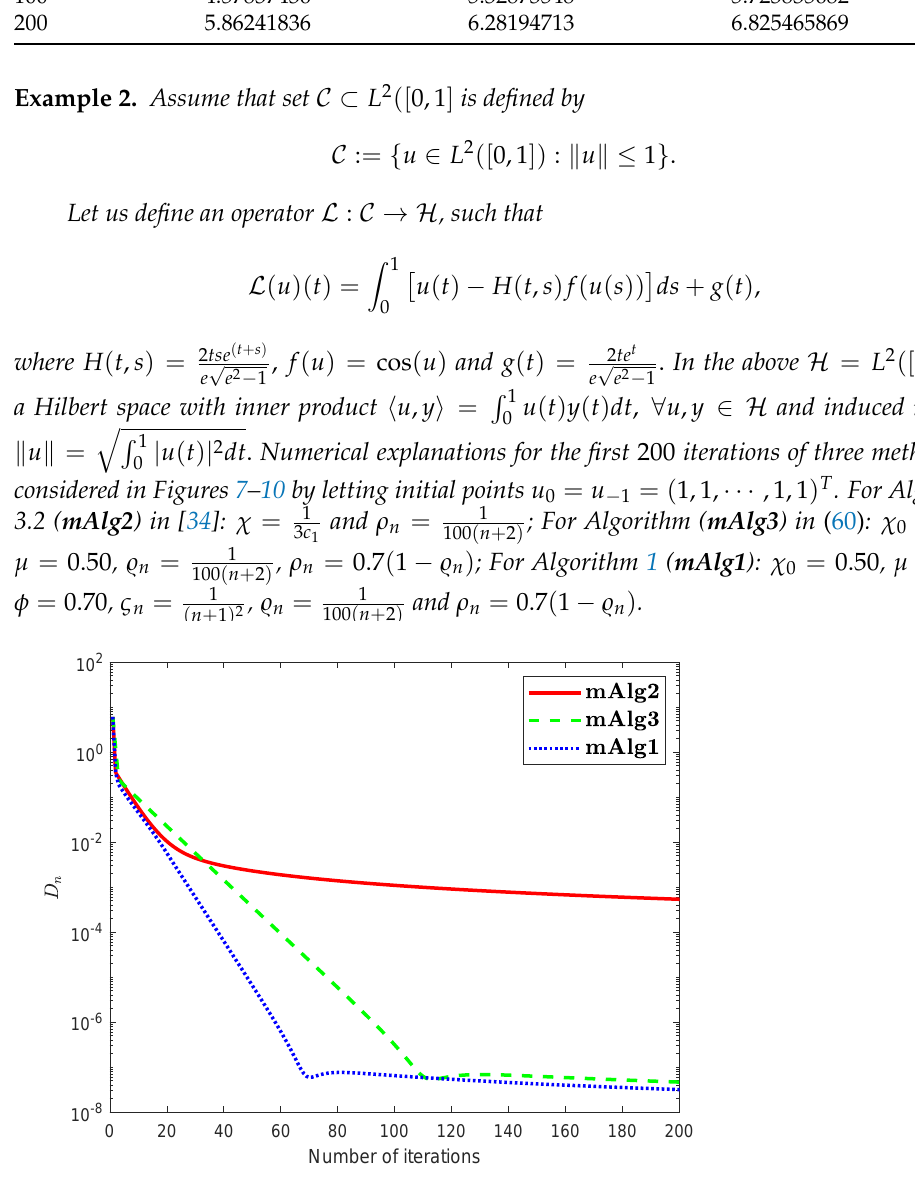
Figure 7. Algorithm 1 compared to Algorithm (60) and Algorithm 3.2 in [34] for u 0 = 1 + t + 2 t 2